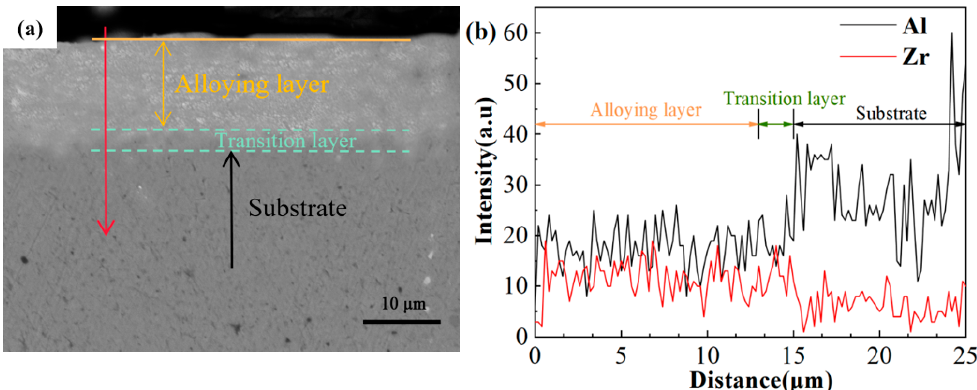
Figure 5. Cross-section EDS images of the 30-pulsed sample: ( a ) the BSE image of the cross-section and ( b ) the result of EDS line scan.